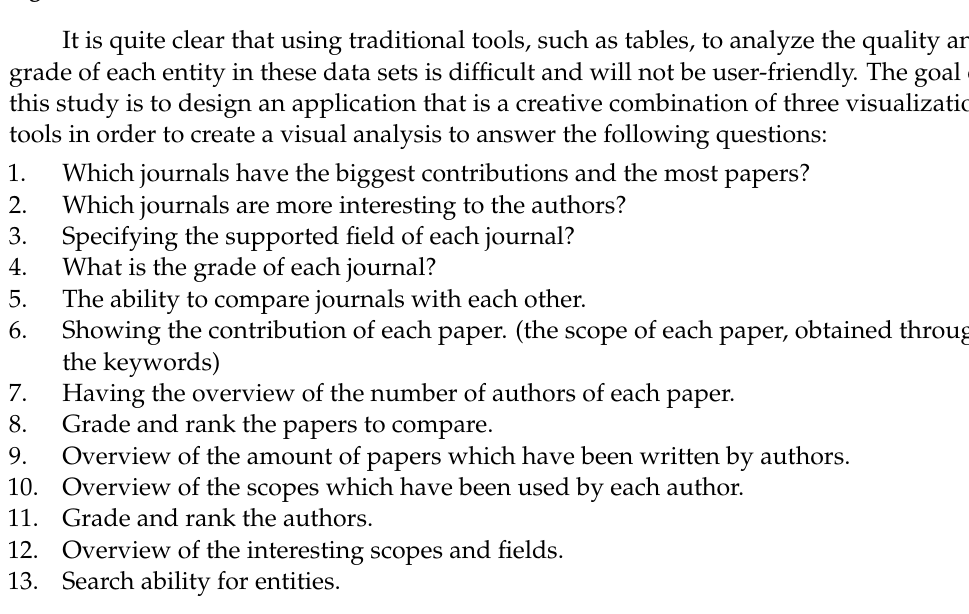
Figure 1. The extracted ER of data